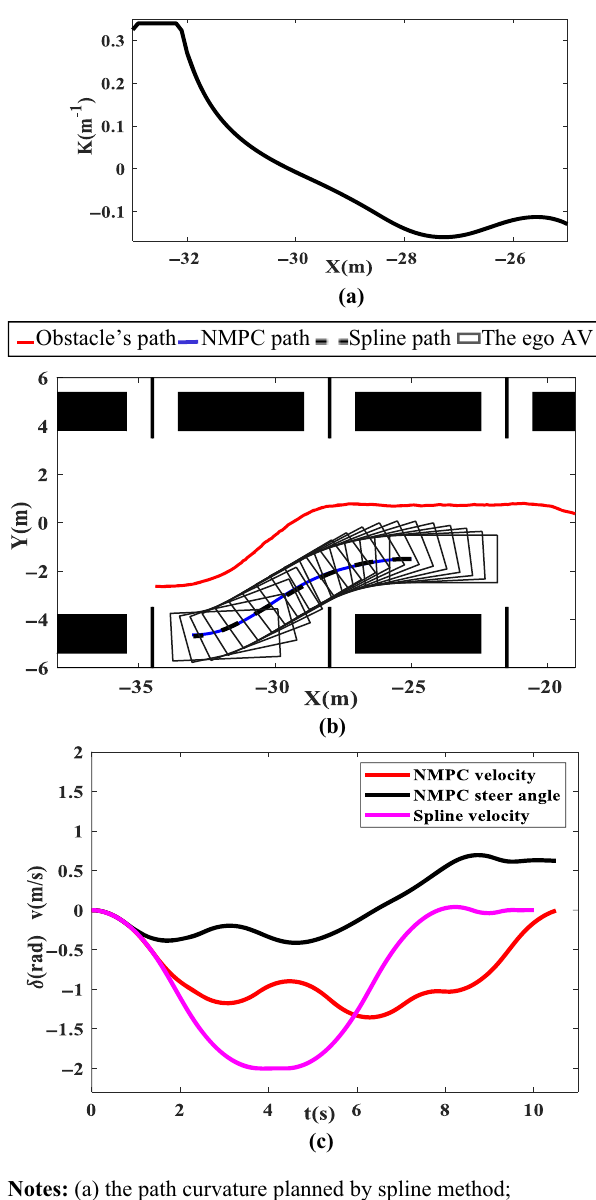
Figure 11 Trajectories planned by different